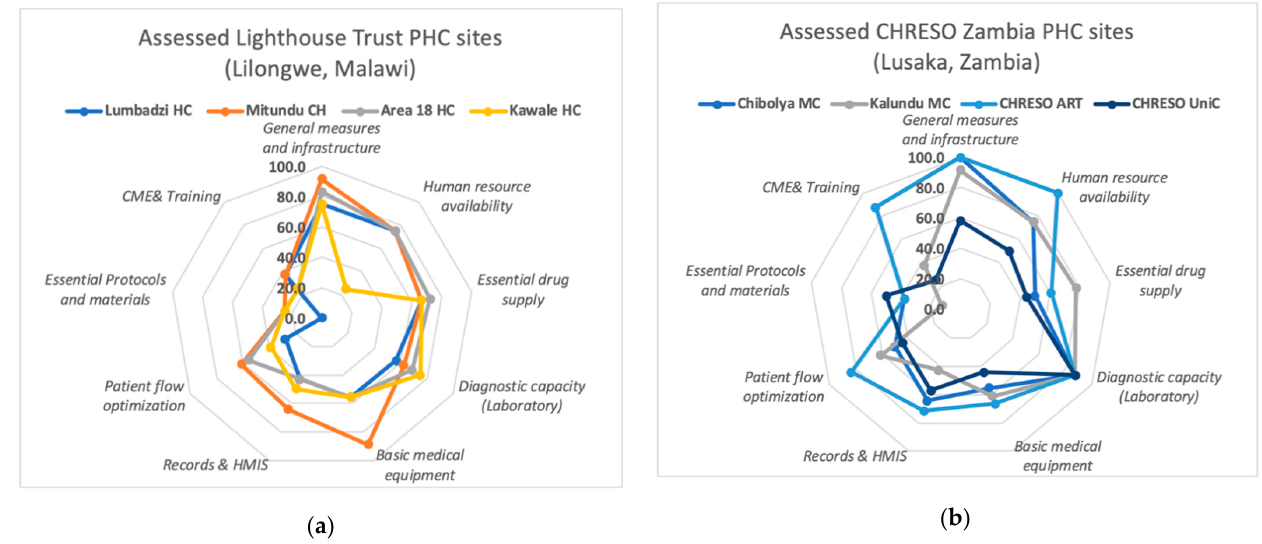
Figure 3 . Spider graphs showing capacity score (by basic service domain requirements) for NCD service integration by assessed PHC sites in Lilongwe ( a ) and Lusaka ( b ).